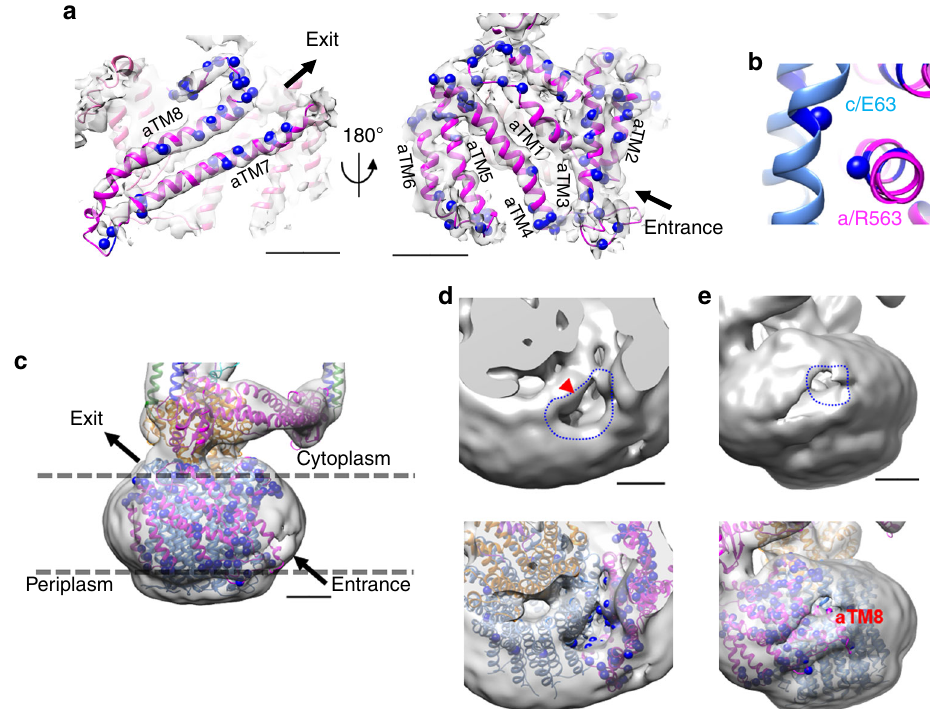
Fig. 5 Structure of the membrane embedded domain. a The side views of the a-subunit. The homology model of the a-subunit was fi tted into the map of state1 by MDFF. Expected paths of proton exit and entrance are shown by black arrow when the enzyme functions as an ATP synthase. Polar residues are depicted in blue sphere format. Scale bar, = 20 Å. b A magni fi ed view of contact surface between the c-ring and the a-subunit at cytoplasmic pore. The essential residues coupled protonation (E63 on c-subunit and R563 on a-subunit) are shown by sphere format. c Overview of the membrane embedded domain. The directions of the proton fl ow indicated by black arrows correspond to a. Scale bar, 20 Å. d , e Close-up views from the cytoplasmic ( d ) and periplasmic ( e ) side. Large cavities are outlined in blue. Viewed from the cytoplasm ( d ), density corresponding to residues indicated in b is apparent (red arrow). Scale bar, 20